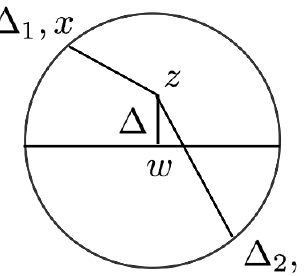
Figure 6. A mirror bulk exchange Witten diagram (cid:22) W bulk in the probe brane setup. Here (cid:22) y is the mirror point of y with respect to the interface, and therefore appears on the other